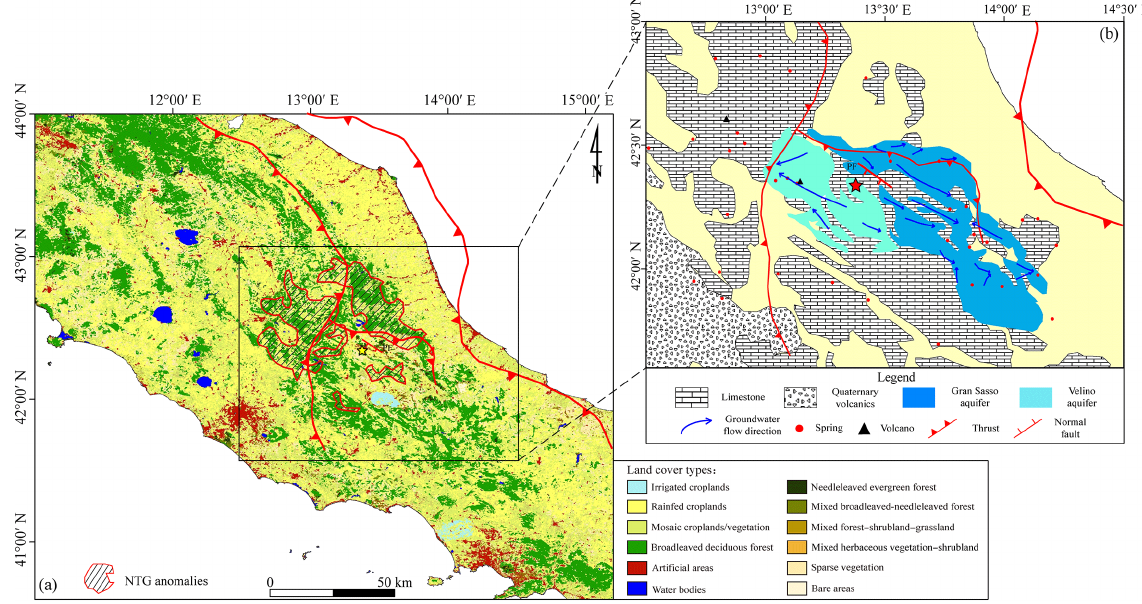
Figure 15. An integrated representation of the geographical (coversphere) and geological (lithosphere) environments associated with the 2009 L’Aquila earthquake. (a) Zones of NTG anomalies from LST (land surface temperature) data overlapped by land covers (Piroddi and Ranieri, 2012); (b) the spatial distribution of tectonic faults, geological rocks, hydrogeological aquifers, and groundwater flows in the epicenter area and its surroundings (Chiodini et al.,